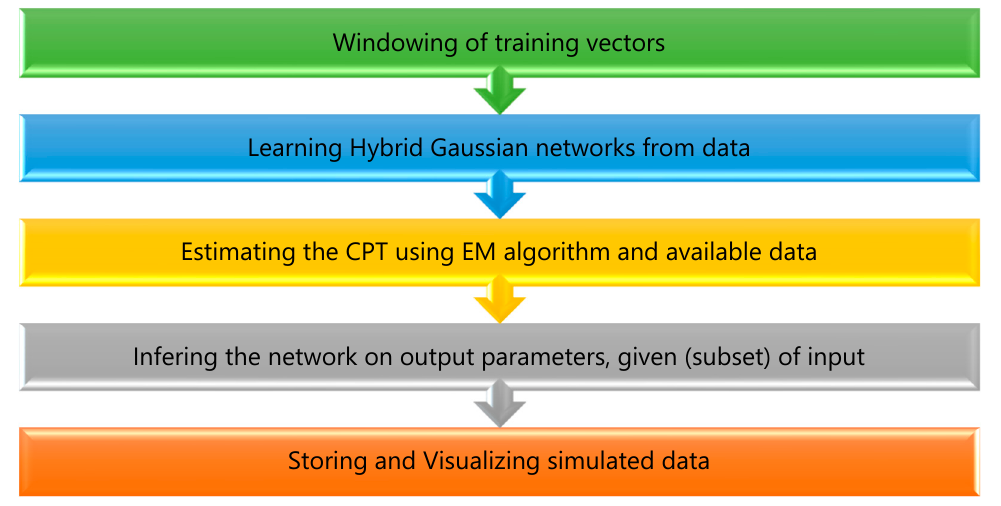
Figure 10. The description of the simulation phase.